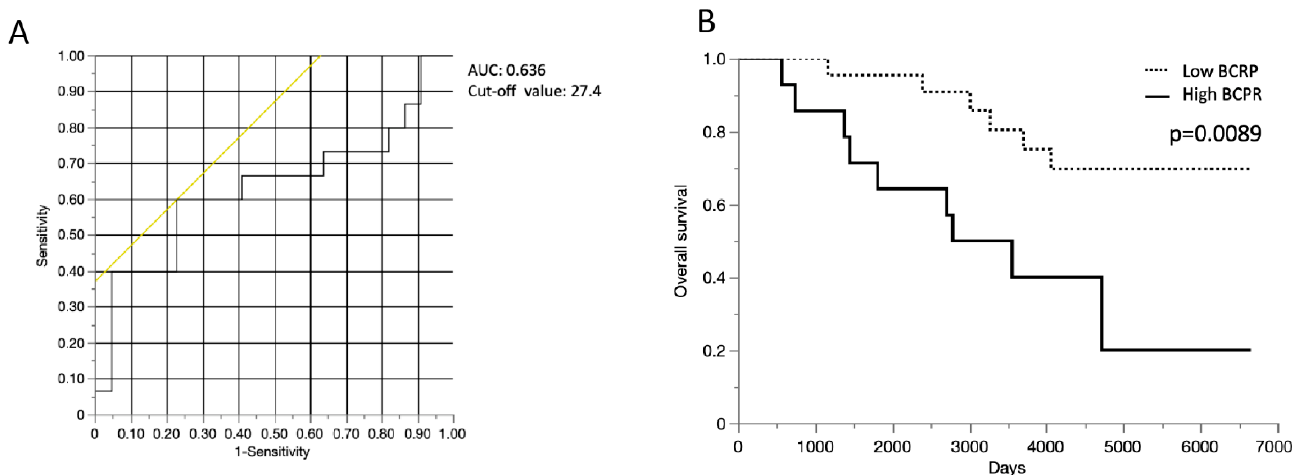
Table 4. Univariate and multivariate analyses of in fl uencing factors of overall survival ( n = 37). Univariate Multivariate